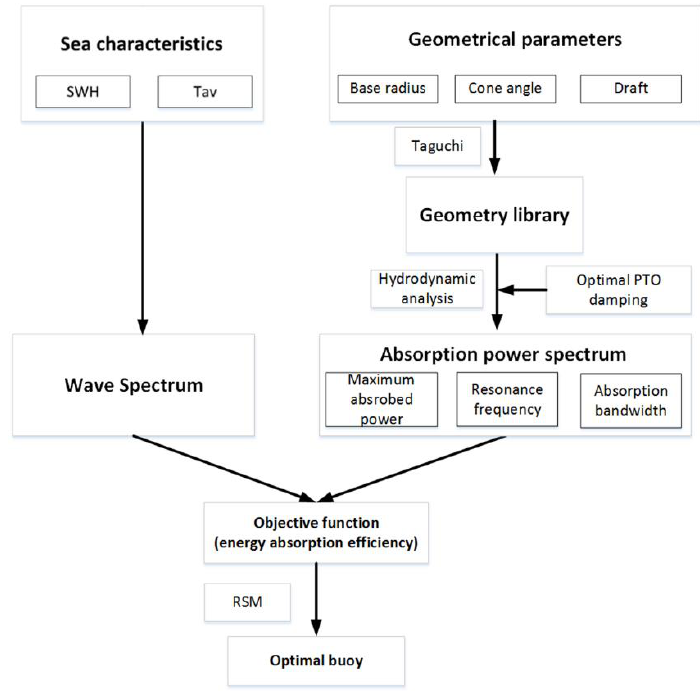
Figure 2. Flowchart of geometrical optimization.